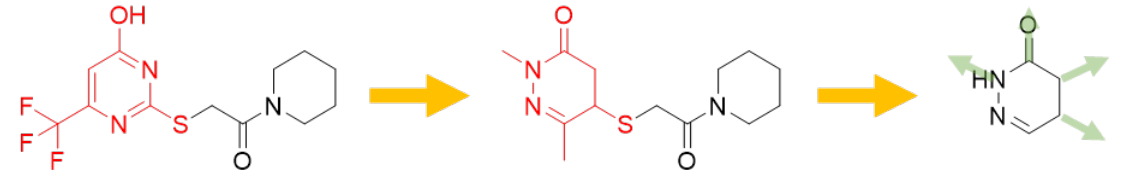
Figure 1. Schematic representation of the computer assisted design of the 4-amino and 4-ureido pyridazinones. Table 1. 4-NH 2 -pyridazinones synthesized and screened against FABP4.